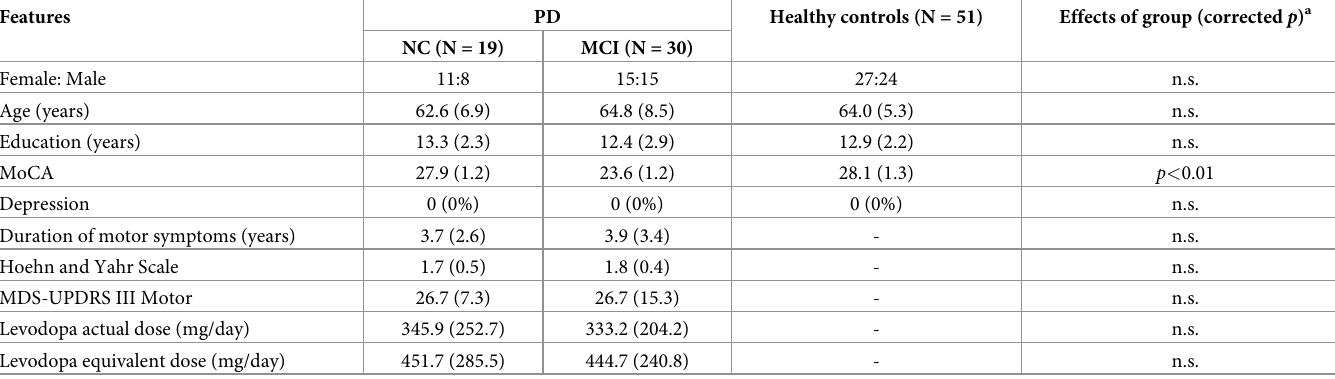
Table 1. Demographic and clinical features of PD patients and healthy